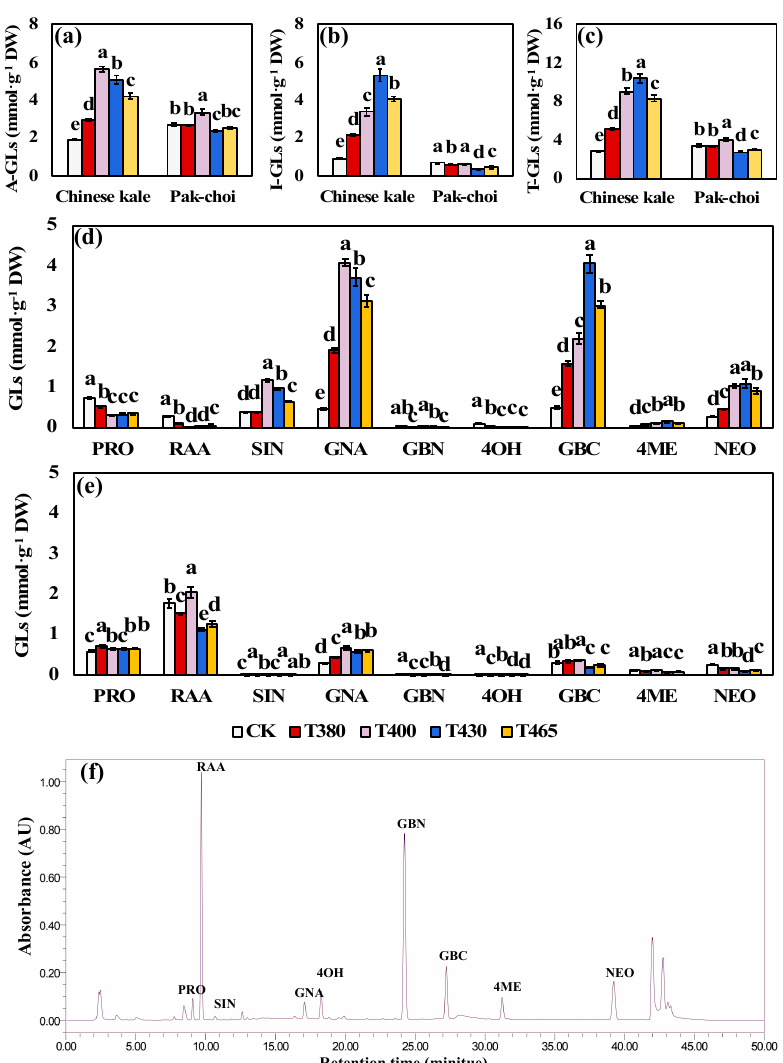
Figure 3. Glucosinolate of two baby-leaves under different wavebands of blue and UV-A light. The contents of ( a ) aliphatic, ( b ) indolic, and ( c ) total glucosinolates. The individual glucosinolate content in ( d ) Chinese kale and ( e ) pak-choi. Identification of nine glucosinolates ( f ) from high performance liquid chromatography. A-GLs = aliphatic flucosinolates, I-GLs = indolic glucosinolates, T-GLs = total glucosinolates, PRO = progoitrin, RAA = glucoraphanin, SIN = sinigrin, GNA = gluconapin, GBN= glucobrassicanapin, 4OH = 4-hydroxyglucobrassicin, GBC = glucobrassicin, 4ME = 4- methoxyglucobrassicin, NEO = neoglucobrassicin. Different letters (a–e) upon the bar plots indicate significant difference at p < 0.05 using one-way analysis of variance with Duncan’s multiple-range test.